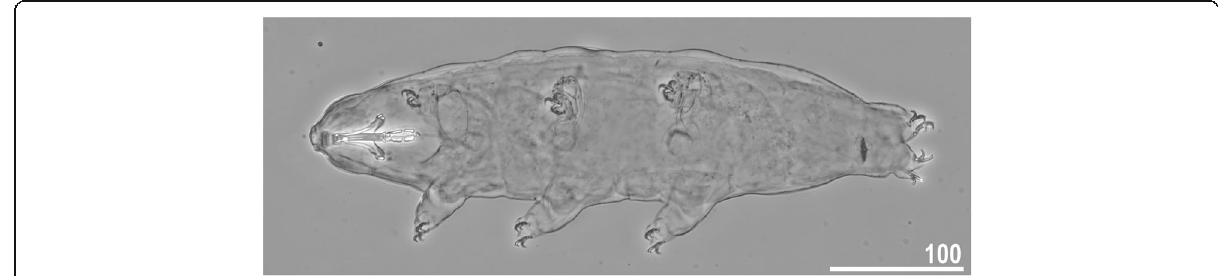
Fig. 21 Macrobiotus ripperi sp. nov. from Poland (PL.015) – habitus, adult specimen in dorso-ventral projection (holotype). Scale bar in μ m